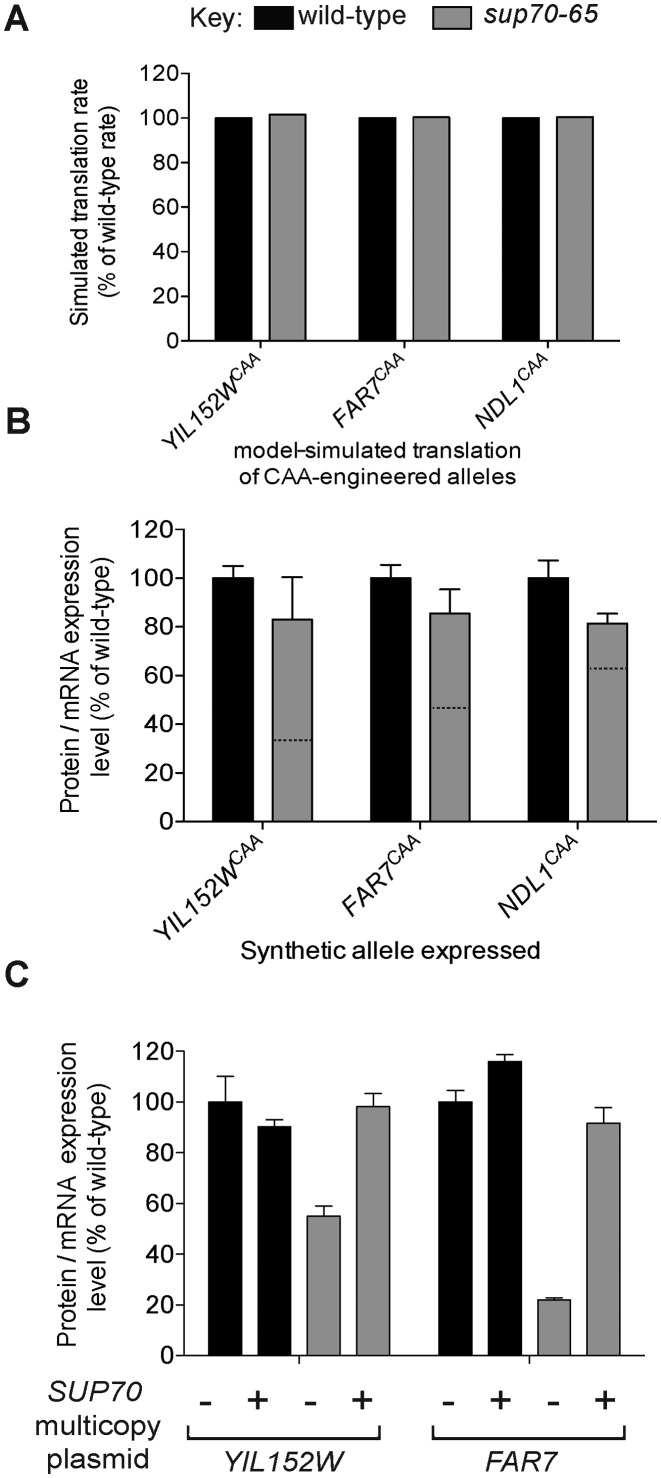
Codon engineering of genes regulated by \documentclass[12pt]{minimal}
\usepackage{amsmath}
\usepackage{wasysym}
\usepackage{amsfonts}
\usepackage{amssymb}
\usepackage{amsbsy}
\usepackage{upgreek}
\usepackage{mathrsfs}
\setlength{\oddsidemargin}{-69pt}
\begin{document}
}{}${\rm{tRNA}}_{{\rm{CUG}}}^{{\rm{Gln}}}$\end{document} ablates their sensitivity to rare glutamine codon concentration. (A) Three target mRNAs known to be under-expressed in a sup70-65 yeast were selected. In silico, all CAG codons within each ORF were replaced by synonymous CAA codons. Using the two-state TASEP model, their translation efficiency was compared in a wild-type and sup70-65 simulation (dark and light grey bars respectively). (B) Synthetic variants of the same three ORFs were prepared (e.g. FAR7CAA) in which all CAG codons were replaced by CAA. Their expression levels were compared in wild-type (dark bars) and sup70-65 mutant yeast (light bars) using quantitative Western blotting normalised for mRNA expression level as in Figure 3 (n = 3, ± SE). For reference, the expression level of the progenitor, CAG-containing allele, (Figure 3B data) is shown by the dashed lines. (C) Expression levels of \documentclass[12pt]{minimal}
\usepackage{amsmath}
\usepackage{wasysym}
\usepackage{amsfonts}
\usepackage{amssymb}
\usepackage{amsbsy}
\usepackage{upgreek}
\usepackage{mathrsfs}
\setlength{\oddsidemargin}{-69pt}
\begin{document}
}{}${\rm{tRNA}}_{{\rm{CUG}}}^{{\rm{Gln}}}$\end{document}-sensitive target genes YIL152W and FAR7 were compared in wild-type and sup70-65 mutant yeast using quantitative Western blotting normalised by measured mRNA levels, in the presence and absence of ectopically-expressed SUP70 wild-type \documentclass[12pt]{minimal}
\usepackage{amsmath}
\usepackage{wasysym}
\usepackage{amsfonts}
\usepackage{amssymb}
\usepackage{amsbsy}
\usepackage{upgreek}
\usepackage{mathrsfs}
\setlength{\oddsidemargin}{-69pt}
\begin{document}
}{}${\rm{tRNA}}_{{\rm{CUG}}}^{{\rm{Gln}}}$\end{document} (n = 3, ± SE). The tRNA-encoding SUP70 gene was transformed on a multicopy plasmid to ensure high-level \documentclass[12pt]{minimal}
\usepackage{amsmath}
\usepackage{wasysym}
\usepackage{amsfonts}
\usepackage{amssymb}
\usepackage{amsbsy}
\usepackage{upgreek}
\usepackage{mathrsfs}
\setlength{\oddsidemargin}{-69pt}
\begin{document}
}{}${\rm{tRNA}}_{{\rm{CUG}}}^{{\rm{Gln}}}$\end{document} expression.